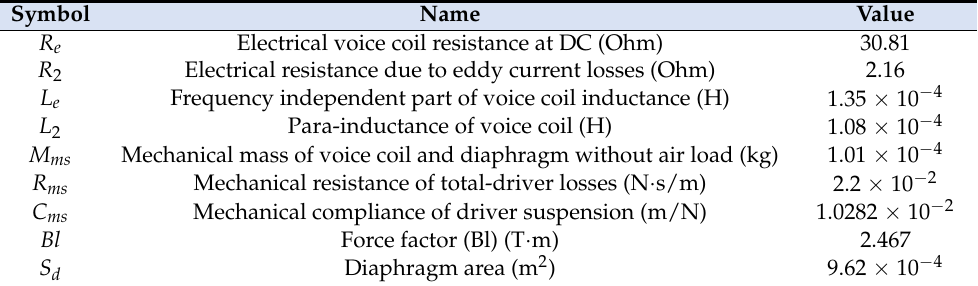
Table 4. Thiele/Small (T/S) parameters of DSH742-005.